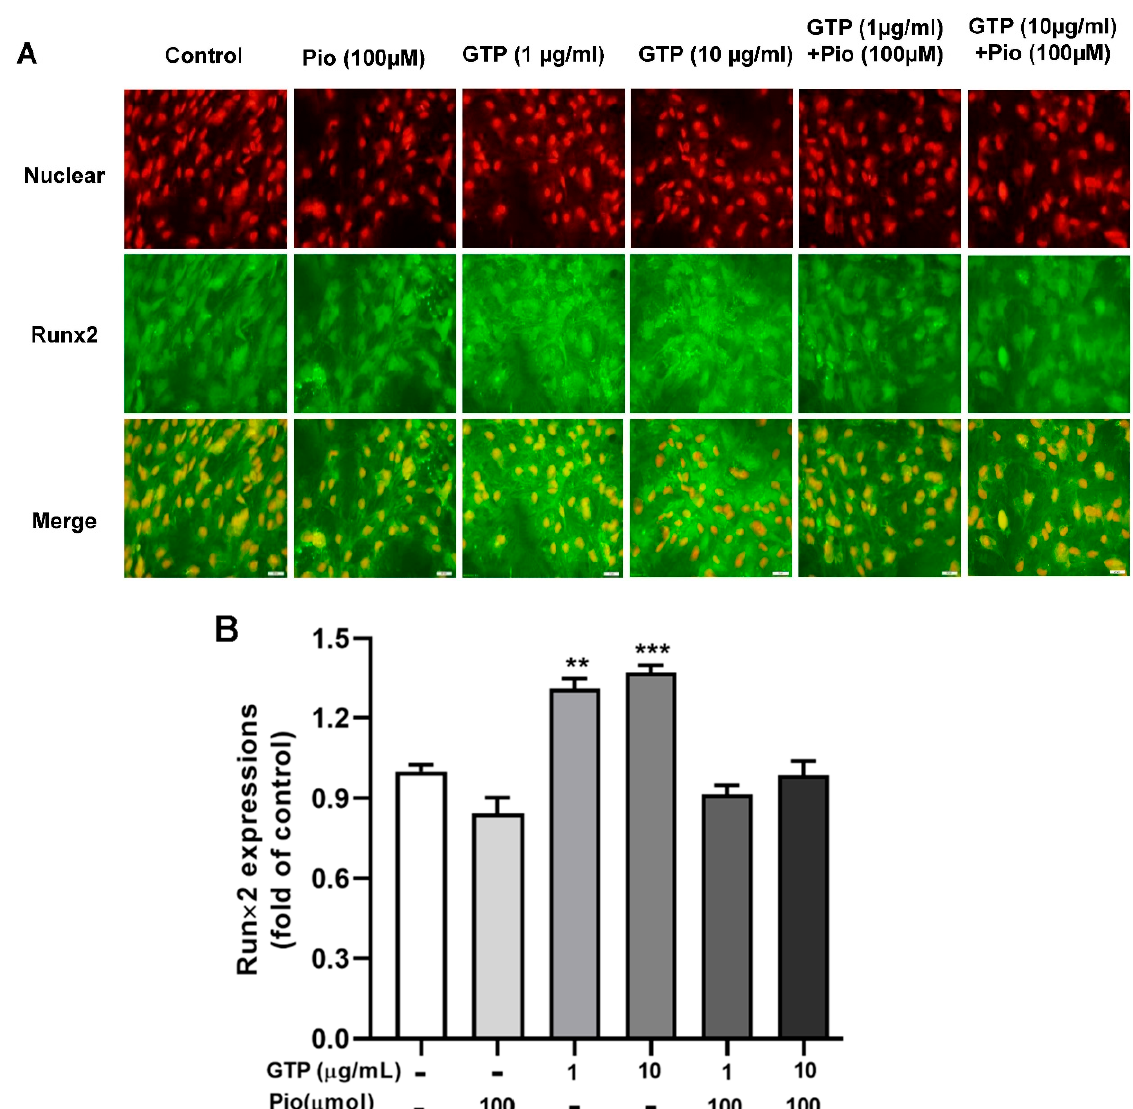
Figure 5. Green tea polyphenols (GTPs) enhance Runx2 protein expression during hADSC toward oestrogenic differentiation. Images of immunofluorescence staining ( A ) showed Runx2 protein contents stained as green in cells treated with pioglitazone (Pio, 100 µmol), 1 and 10 µg/mL of GTPs and the combination of GTPs and pioglitazone. Quantitative data ( B ) from 4 separate experiments are expressed as means ± SE. ** p < 0.01 and *** p < 0.001 GTPs treatments vs. the control.